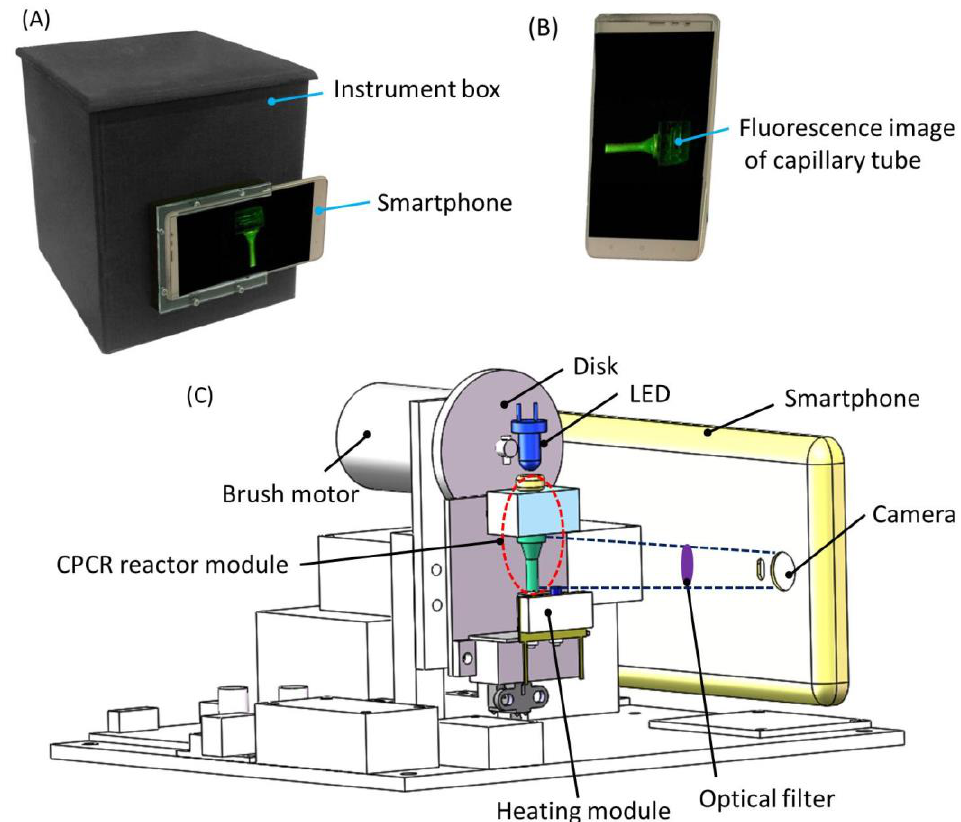
Figure 4. Integrated Microfluidic CPCR NAAT System. ( A ) A photograph of CPCR device in this paper; ( B ) a smartphone and in-situ fluorescent signal collected; ( C ) schematic depiction of CPCR device with centrifugation, heating and fluorescence detection modules.